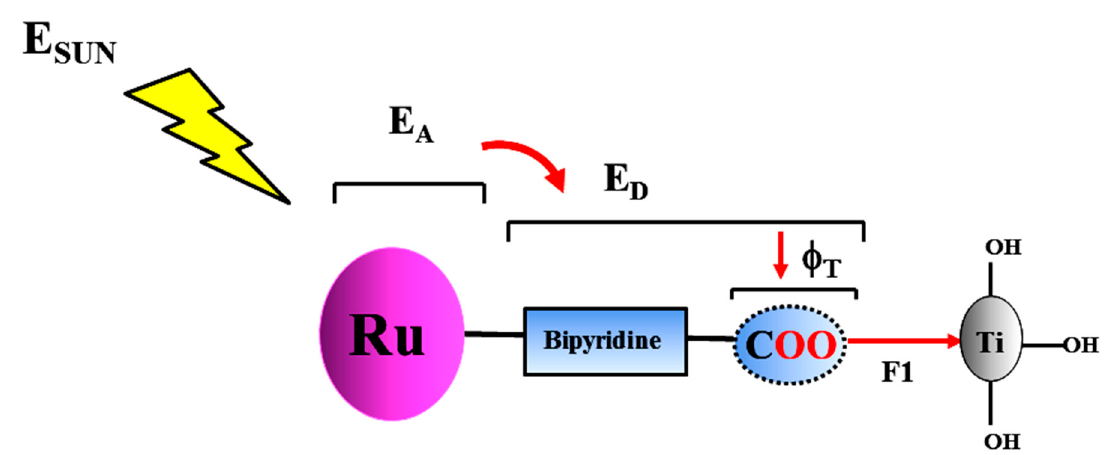
Figure 23. Scheme showing the composition of the F1 index.